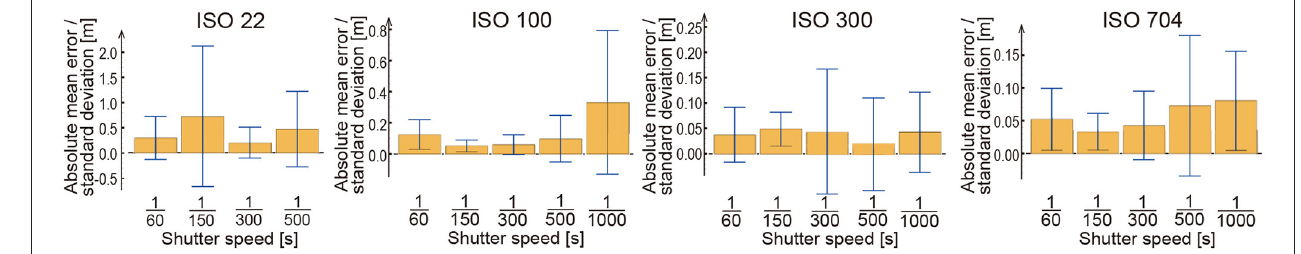
FIGURE 5 | Absolute mean errors (rectangular bars) and standard deviations (error bars) of the estimated distance for each ISO and shutter speed setting.